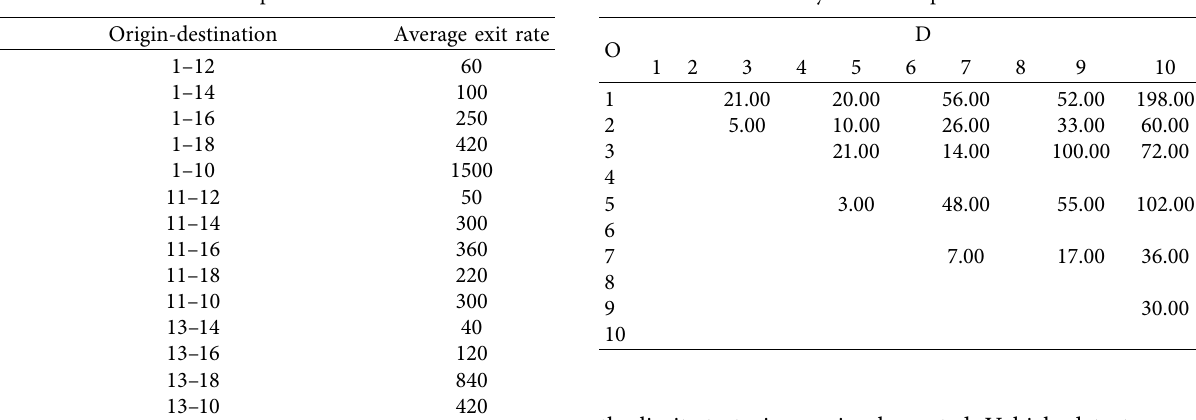
Table 2: The OD pairs in network. Table 3: Dynamic OD prediction